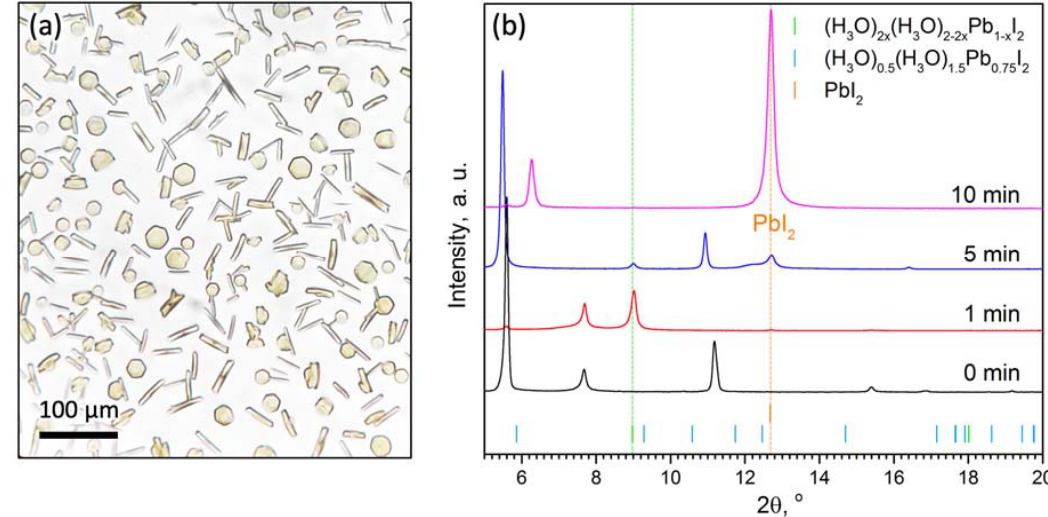
Figure 1. ( a ) Appearance of the crystals of the Phase-1 grown in drop of solution; ( b ) Evolution of the film deposited from 0.375 M solution of HI:PbI 2 = 1:1 in acetone. Positions of the reflections of the known phases (PbI 2 , (H 3 O) 0.5 (H 2 O) 1.5 Pb 0.75 I 2 ), and (H 3 O) 2x (H 2 O) 2–2x Pb 1–x I 2 (x ≈ 0.23)) are indicated by colored bars.